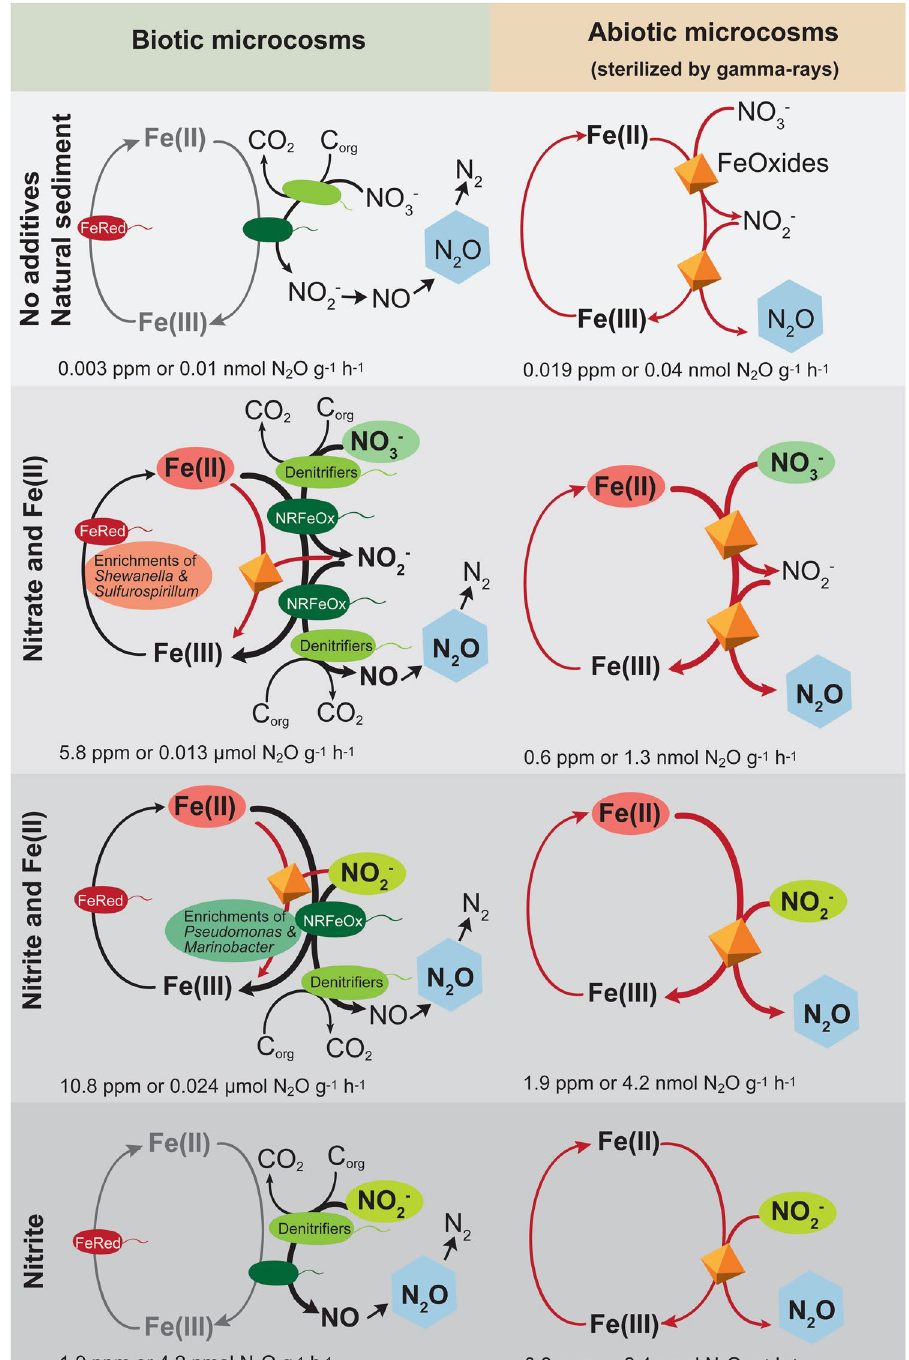
Figure 2. Conceptual model of the influences of nitrate or nitrite on microbial Fe-cycling and N 2 O production based on the detected N of microcosm experiments with marine sediment from Norsminde Fjord amended with Fe(II) and nitrate, Fe(II) and nitrite (Fig. 1); or amended with nitrite only and native sediment (Fig. S1) (sterilized and microbially active setups). Thickness of lines and differences in symbol size indicate the relative importance. Heterotrophic denitrifiers are marked in light green, nitrate-reducing Fe(II)-oxidizers (NRFeOx) in dark green, and Fe(III)- reducers (FeRed) in red. Chemodenitrification reactions (abiotic reduction of nitrite by Fe(II), green rust or siderite) are highlighted in red. The orange mineral particle stands for iron minerals (e.g. FeOOH, green rust,